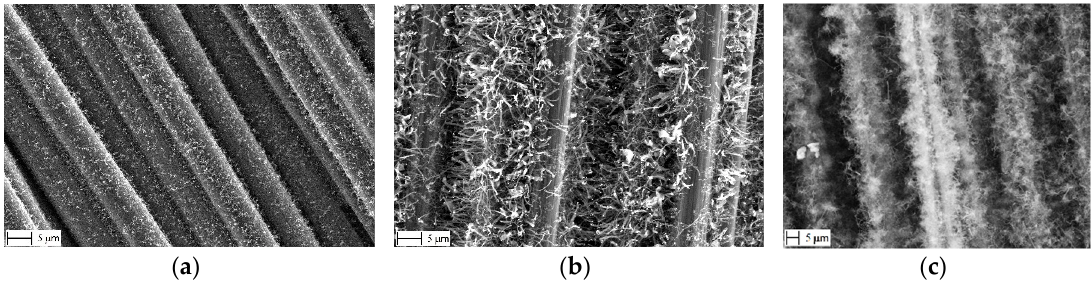
Figure 2. Typical SEM images of grafted fibers: 5 wt % ( a ) and about 10–20 wt % ( b , c ).